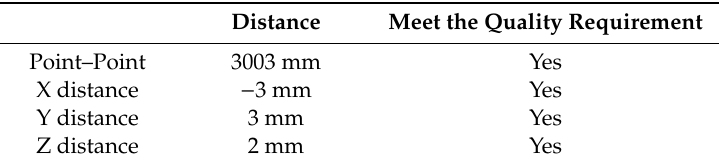
Table 3. Deviation from the center point to the center point. Figure 17. Comparison between BIM and point cloud data.